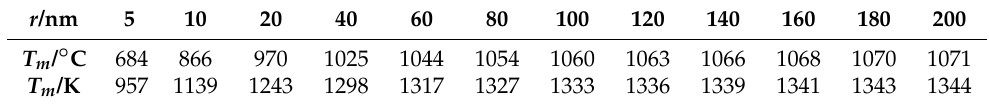
Table 2. The melting point of copper nanoparticles as a function of the particle size.